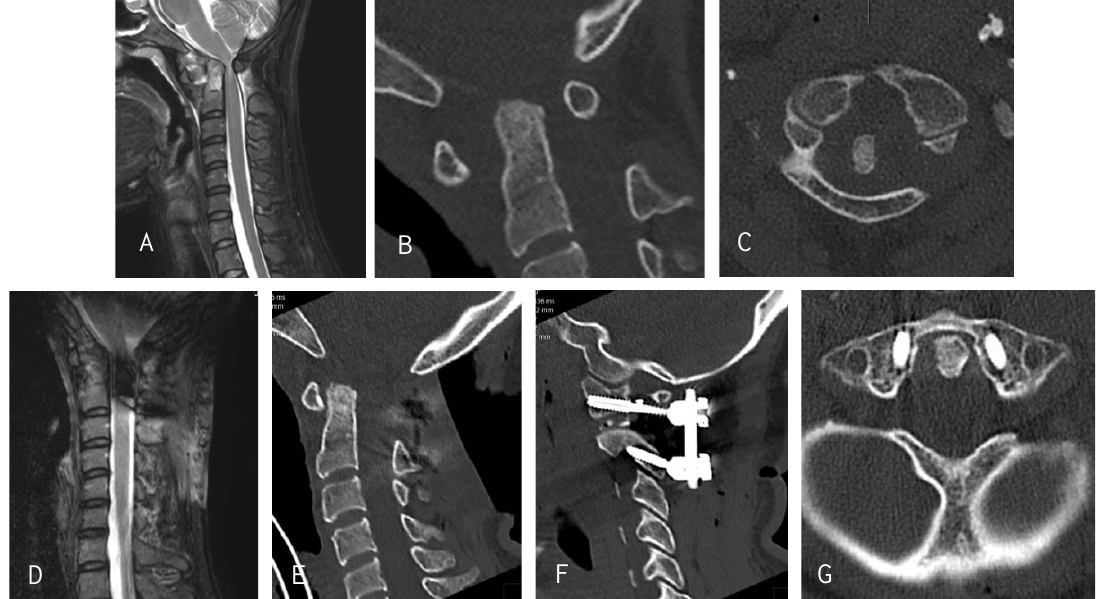
Figure 3. ( A )Preoperative MRI imaging of the cervical spine atlantodental instability with retrodental pannus formation and basilar impression due to dorsal displacement of the dens resulting in absolute spinal constriction and myelopathy. ( B , C ) Enlarged anterior atlantodental interval in the preoperative scan (AADI). ( D – G ) Postoperative imaging after initially closed and then open reduction and fixation C1-2.